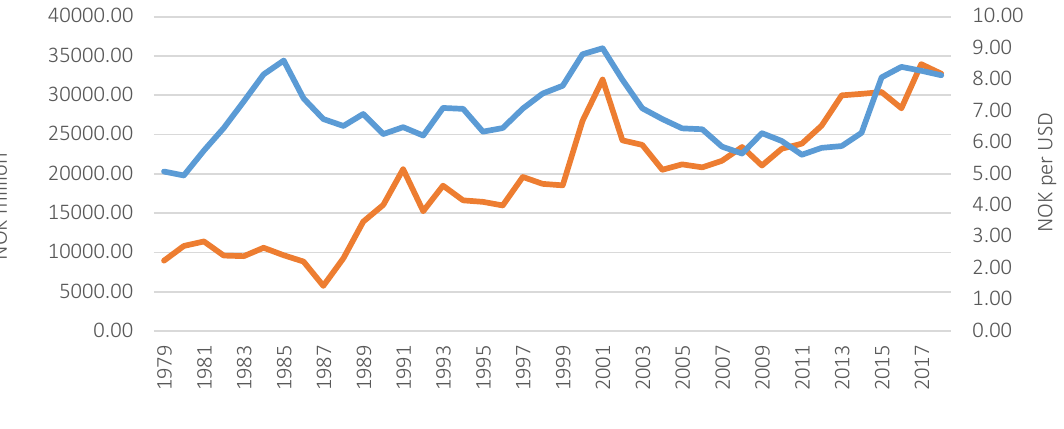
Figure 7. Development in official exchange rate with USD relative to NOK and ocean transport value added during the period